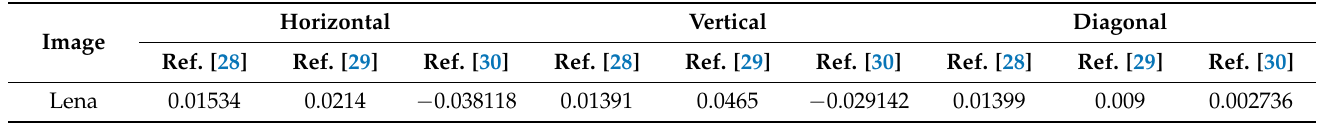
Table 5. The comparison of image correlation